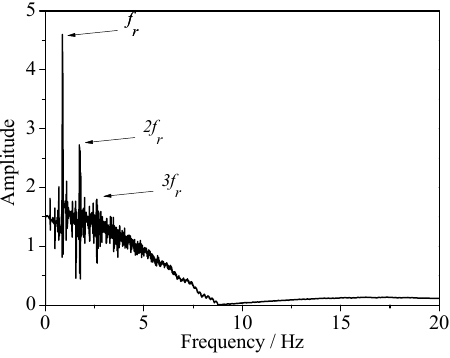
Figure 4. Radial vibration frequency spectrum of planet carrier bearing.